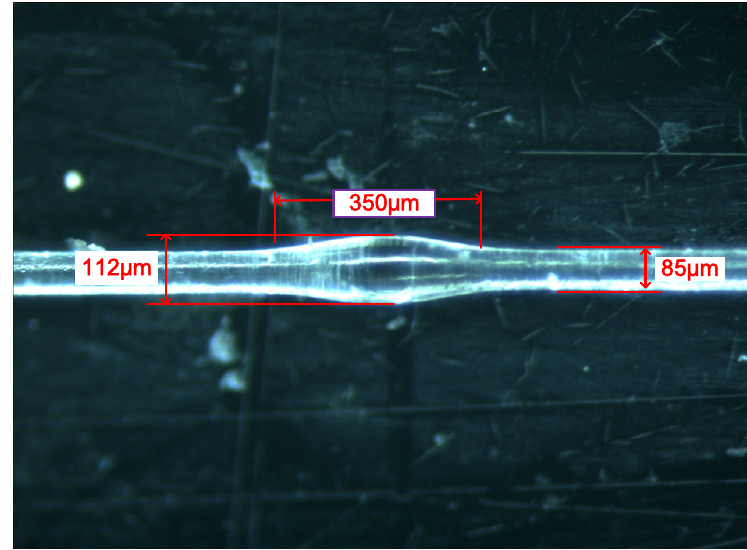
Figure 8. The etched waist-enlarged bitaper in ESMBMS MZI.